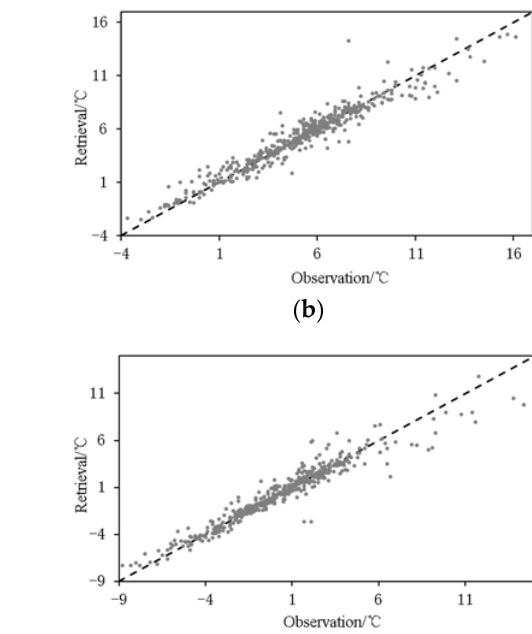
1 ( c ), and bridge deck station 2 ( d ).